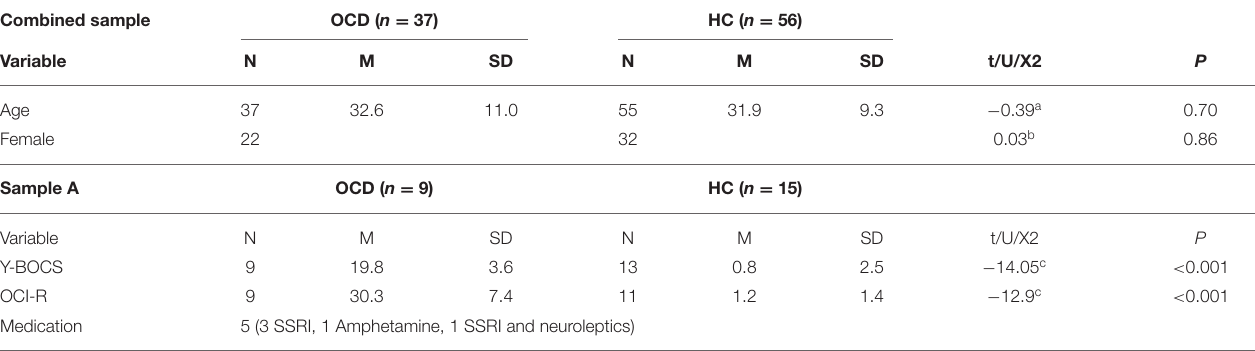
TABLE 1 | Demographic and psychometric information of OCD and healthy controls in the combined sample and sample A. Combined sample Variable